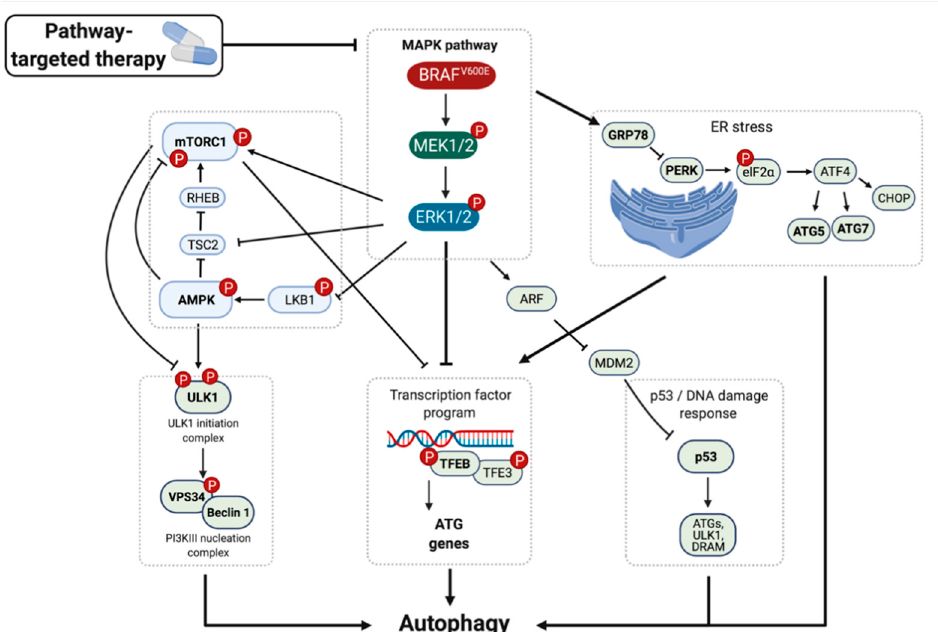
Figure 3. Mechanisms of BRAF inhibitor-induced autophagy. Therapy targeting the MAPK pathway can induce autophagy through several pathways. One way is through direct activation of the MAPK → AMPK/mTOR → ULK1 signaling pathway, leading to activation of VPS34/Beclin1. Another way is through activation of transcription factors, such as TFEB or TFE3, two known master regulators of the expression of key autophagy genes. BRAF inhibition can also induce autophagy through activation of the endoplasmic reticulum (ER) stress gatekeeper GRP78, leading to the activation of ATF4 and transcription of ATG genes. Moreover, the tumor suppressor p53 can induce the transcription of several ATGs, as well as ULK1 and DRAM, resulting in upregulation of autophagy. In theory, MAPK-mediated ARF activation can induce p53, although whether this pathway is used by MAPK-inhibitor exposed cancer cells to upregulate autophagy has not been shown.